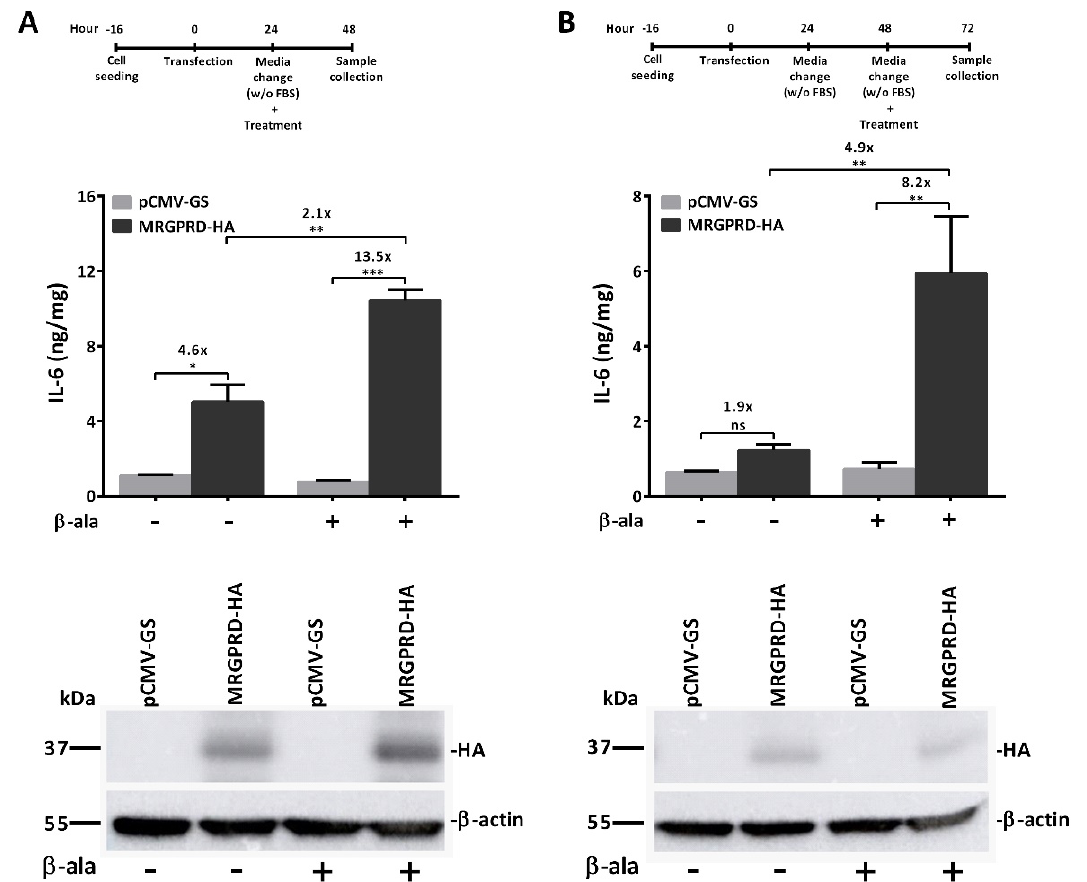
Figure 3. IL-6 assay optimization. To achieve a high dynamic window for the IL-6 detection, the experiment timeline was optimized. ( A ) At 24 h post-transfection, medium was replaced by FBS-free medium, and cells were treated with vehicle or β -alanine (100 µ M). At 24 h post-treatment, i.e., at 48 h post-transfection, samples were collected for IL-6 detection. IL-6 levels from β -alanine-treated MRGPRD-expressing cells were 2-fold higher when compared to those from vehicle-treated MRGPRD-expressing cells. ( B ) Similarly, at 24 h post-transfection, medium was replaced by FBS-free medium for another 24 h, and at 48 h, the medium was once again replaced by FBS-free medium, and cells were treated with vehicle or β -alanine (100 µ M). Samples were collected for IL-6 detection after 24 h of treatment, i.e., at 72 h post-transfection. IL-6 levels from β -alanine-treated MRGPRD-expressing cells were ~5-fold higher when compared to those from only vehicle-treated MRGPRD-expressing cells, which is substantially higher than for the protocol used in ( A ). The cells expressing empty vector (pCMV-GS), treated with β -alanine or vehicle, did not show IL-6 release above the basal level ( A , B ). Below the graphs are representative Western blots of cell lysates from HeLa cells transiently transfected with empty vector (pCMV-GS) or MRGPRD-HA plasmid, showing receptor expression in vehicle or β -alanine (100 µ M)-treated MRGPRD-expressing cells subjected to the experiment timeline protocols illustrated in ( A , B ), respectively. Each graph represents the mean ± s.e.m values from three independent experiments. Statistical significance was determined using one-way ANOVA, and Sidak’s post hoc test was applied for multiple comparisons. * p ≤ 0.05, ** p ≤ 0.01, *** p ≤ 0.001 were considered significant and ‘ns’ is non -significant.